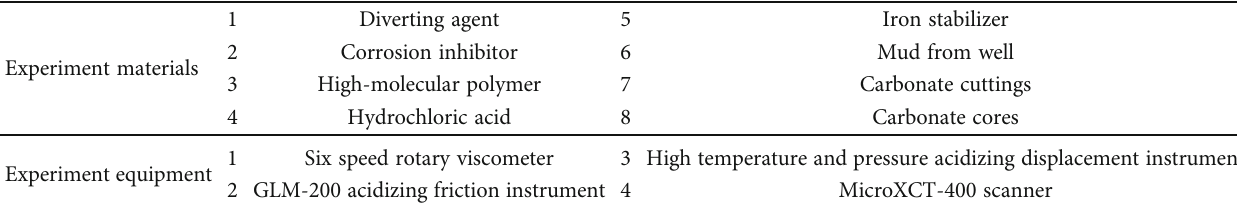
Table 1: Main experiment materials and